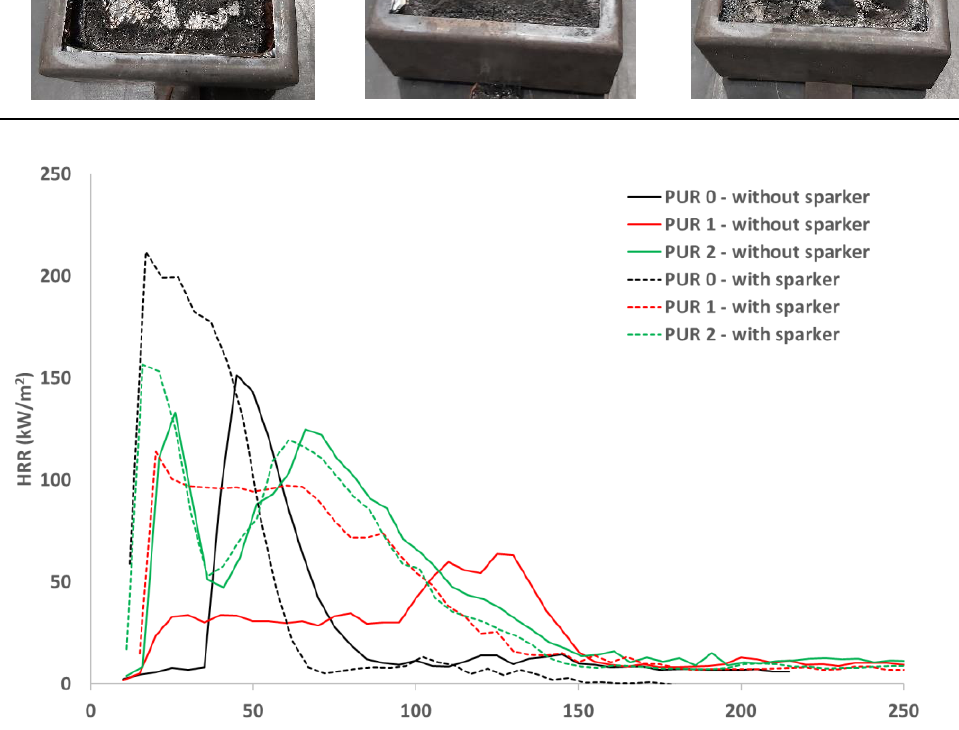
Figure 5. Heat release rate (HRR) of the PURs samples exposed to the 40 kW/m 2 of heat flux; self-ignition and spark ignition.